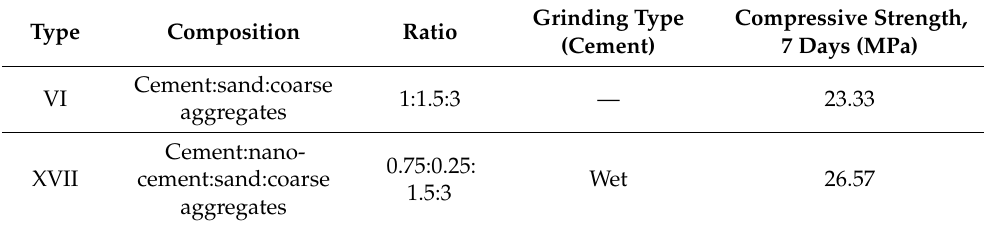
Table 9. Test results of concrete cubes with cement and 25%